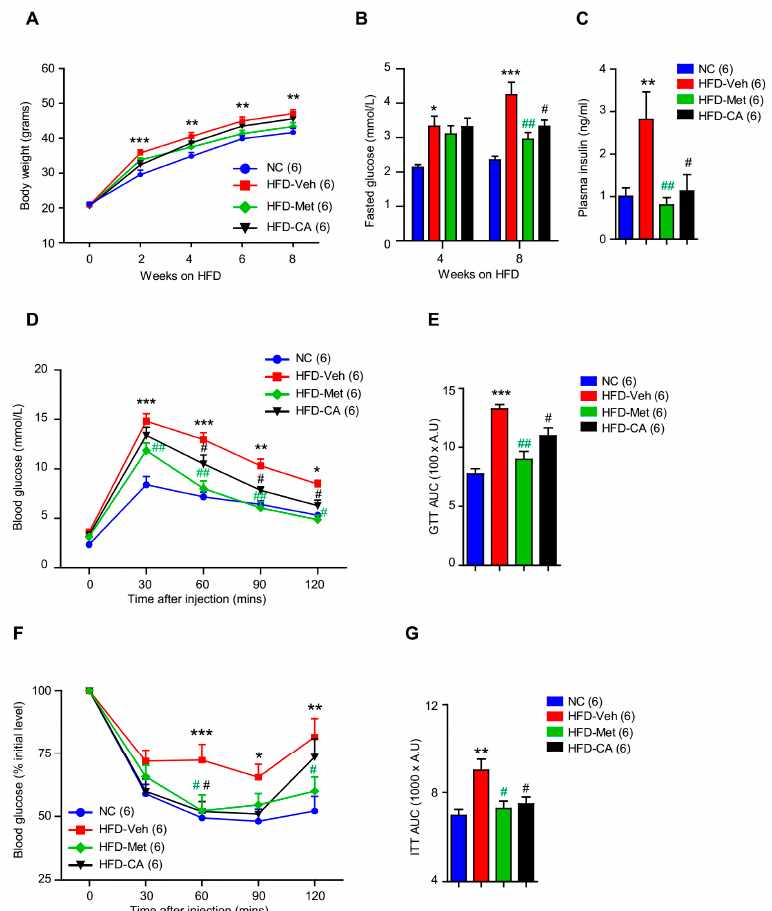
Figure 4. CA treatment improved whole-body glucose homeostasis of mice. ( A ) Body weights of normal chow (NC)-fed mice and high-fat diet (HFD)-fed mice treated with vehicle (veh), metformin (met), and CA for 8 weeks. ( B ) Fasting blood glucose levels of NC-fed mice and HFD-fed mice treated with vehicle, metformin, and CA for 8 weeks. ( C ) Plasma insulin levels of NC-fed mice and HFD-fed mice treated with vehicle, metformin, and CA for 8 weeks. GTT ( D ) and GTT AUC ( E ) of NC-fed mice and HFD-fed mice treated with vehicle, metformin, and CA for 6 weeks. ITT ( F ) and ITT AUC ( G ) of NC-fed mice and HFD-fed mice treated with vehicle, metformin, and CA for 6 weeks. The results are expressed as mean ± SEM. One-way ANOVA with Tukey’s post-hoc tests in bar graphs and two-way ANOVA with Bonferroni post-hoc tests in line graphs. * p < 0.05, ** p < 0.01, *** p < 0.001 compared to NC. # p < 0.05, ## p < 0.01 compared to HFD-Veh.